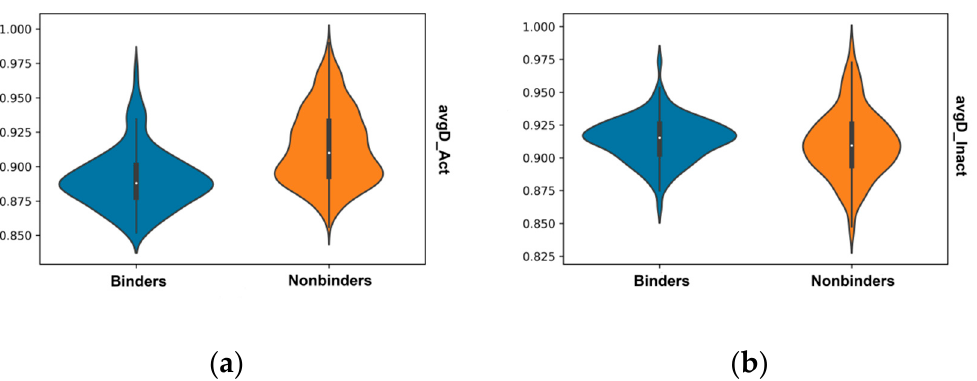
Figure 3. Violin plots of the distributions of average Tanimoto distances of binders (blue) and nonbinders (orange) to: ( a ) known binders (avgD_Act); and to: ( b ) known nonbinders (avgD_Inact).